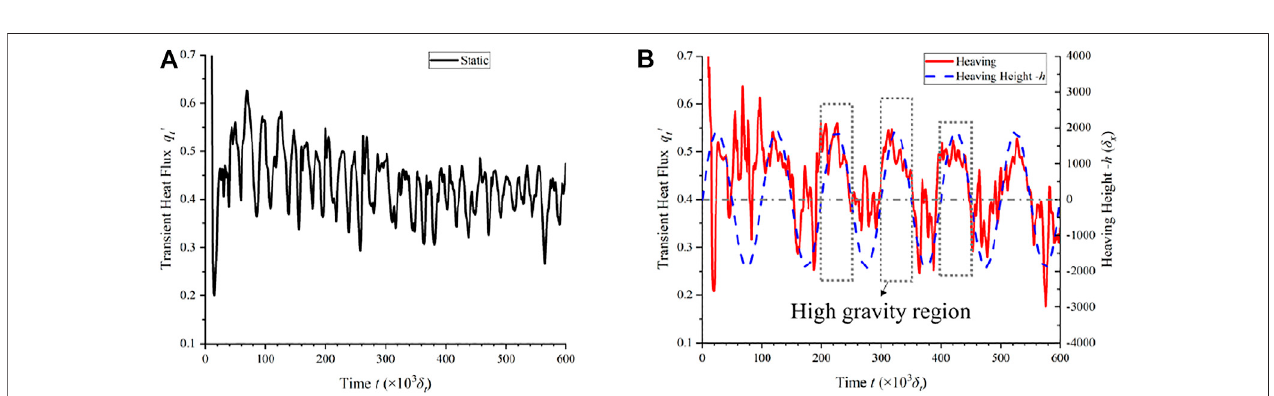
FIGURE 12 | Transient heat fl ux around CHF with Ja (cid:1) 0.186: (A) static condition, and (B) heaving condition. (negative heaving height − h is used here for better observation).